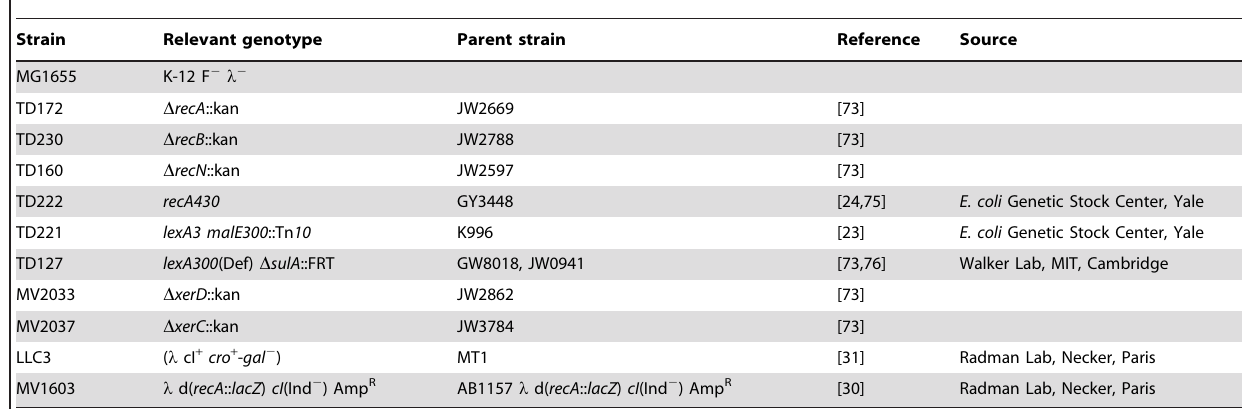
Table 1. Bacterial